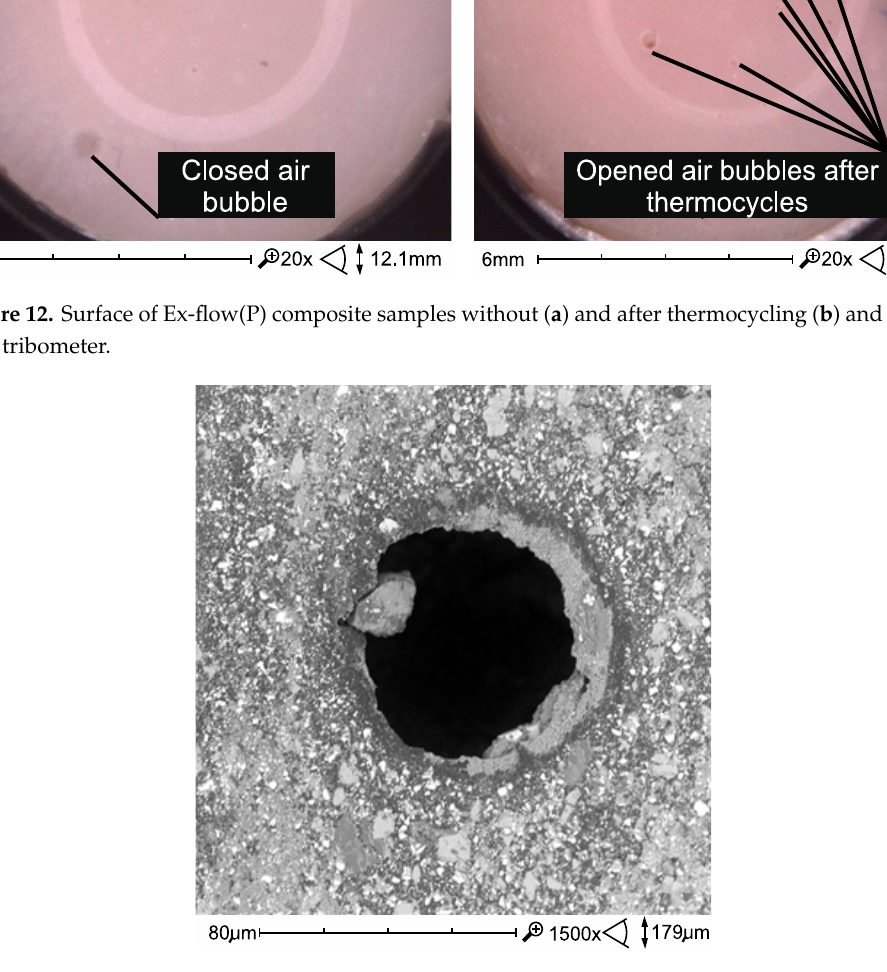
Figure 13. Opened air bubble in Ex-flow(P) composite structure exposed as a result of the combined effect of degradation factors—thermocycling and tribological wear.